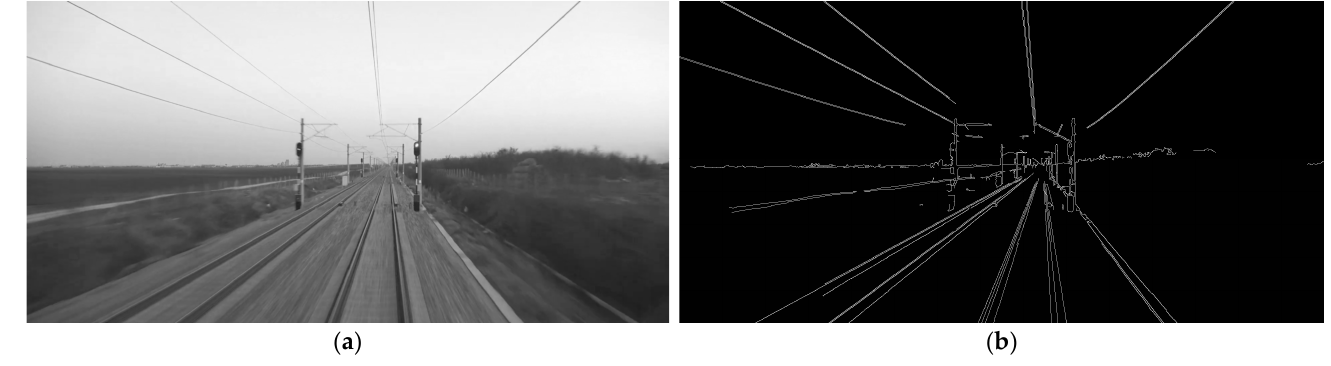
Figure 4. Image processing. ( a ) Blurred image; ( b ) Canny image.